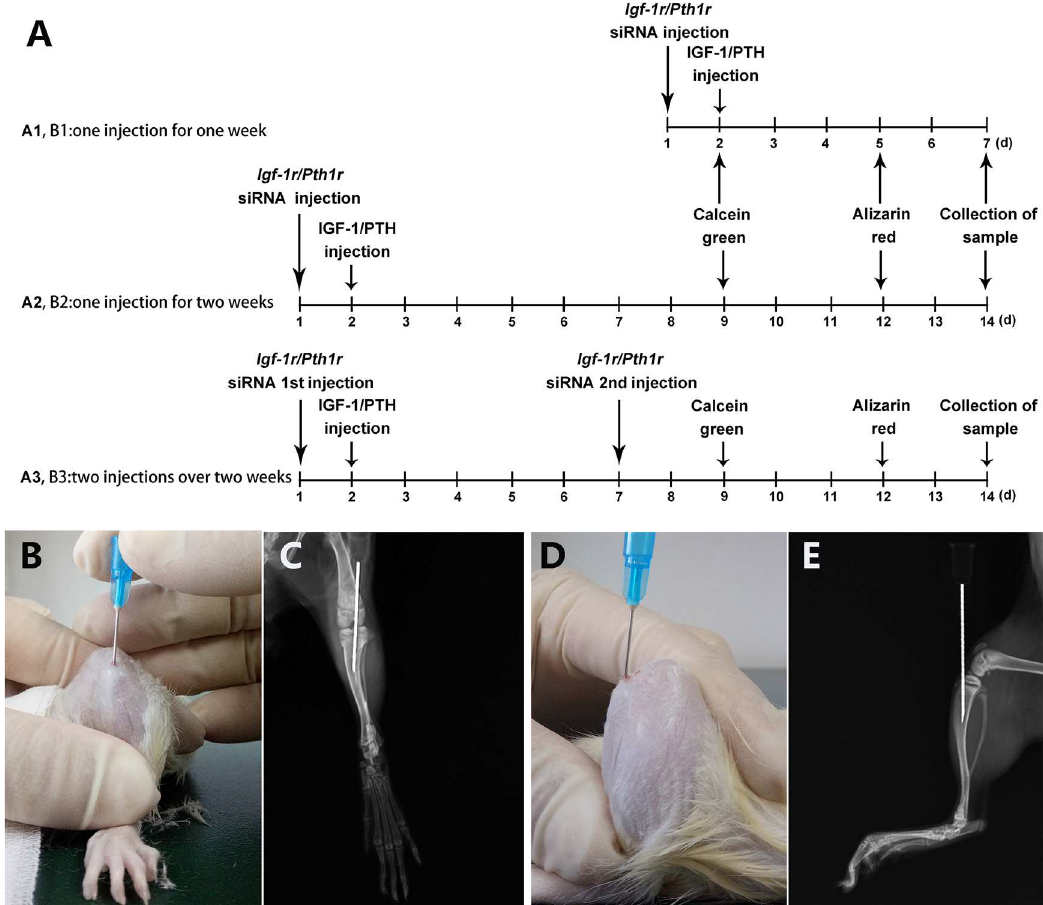
Fig 1. Animal Treatment Protocol and Images of the Intraosseous Injection Location. (A) Animal treatment protocol. (B) Anteroposterior and (D) lateral view of the minimallyinvasivepuncture. The entry point was locatedat the front of the tibial intercondylar eminence,and the needlepath penetrated the tibial plateauparallelto the long axis of the tibia. Representative (C) anteroposterior and (E) lateral X-ray radiographs of the tibia.